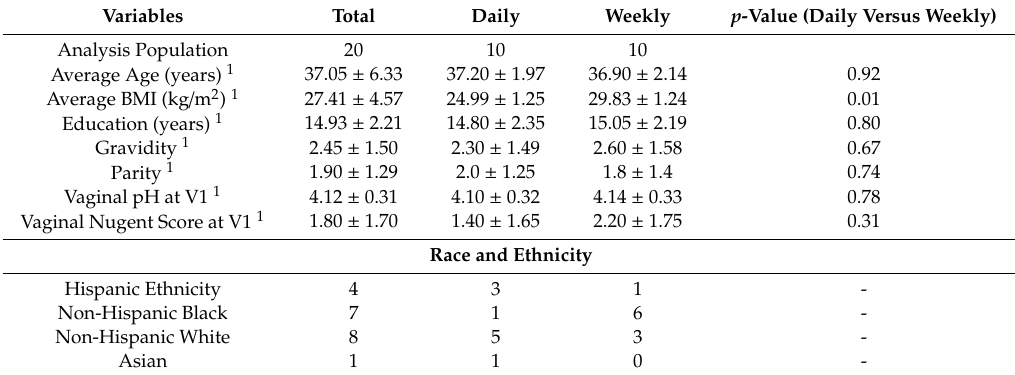
Table 1. Demographics of analysis population.